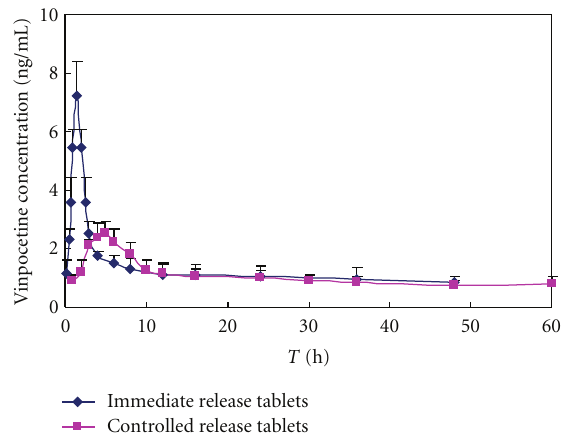
Figure 9: The mean vinpocetine metabolite apovincaminic acid (AVA) plasma concentration-time curves of vinpocetine osmotic pump controlled-release tablets and immediate release tablets after oral administration in dogs ( n = 6, VIN: